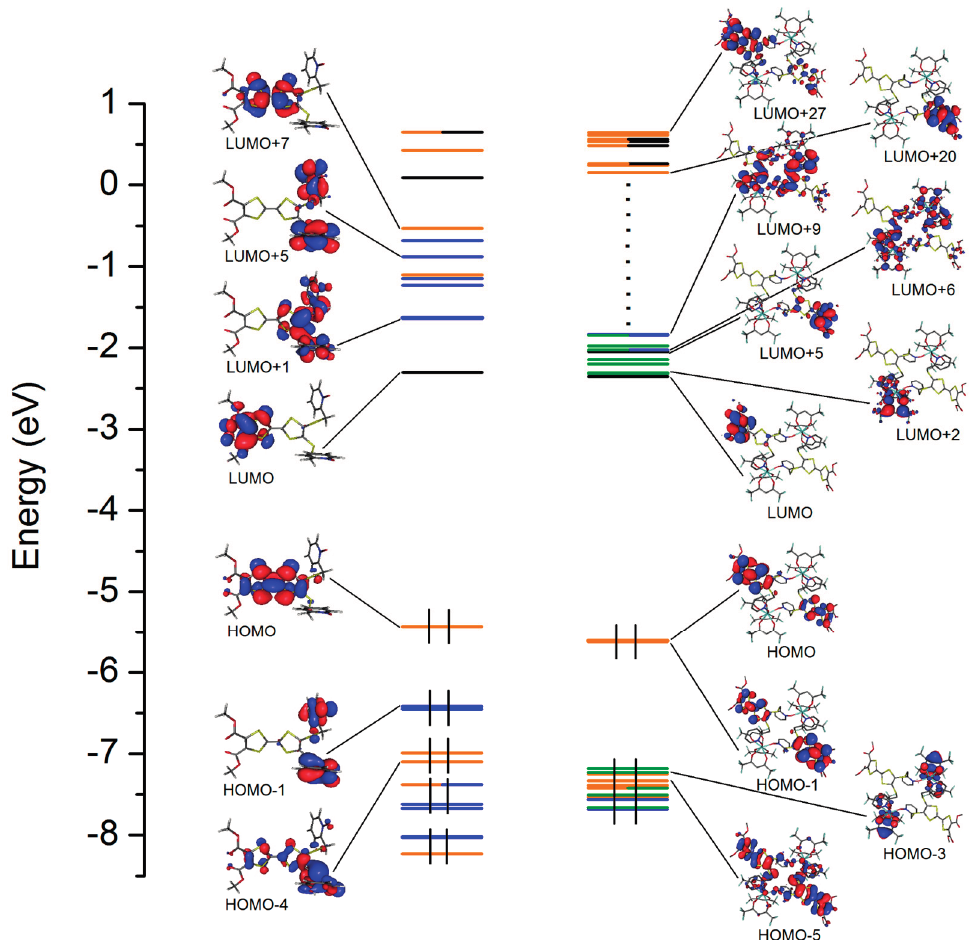
Figure 5. Molecular orbital diagram for L ( left ) and the Y III analogue ( right ). The energy levels of the centred TTF, 2-methylpyridine- N -oxide, methyl ester, and hfac − orbitals are represented in orange, blue, black, and green,